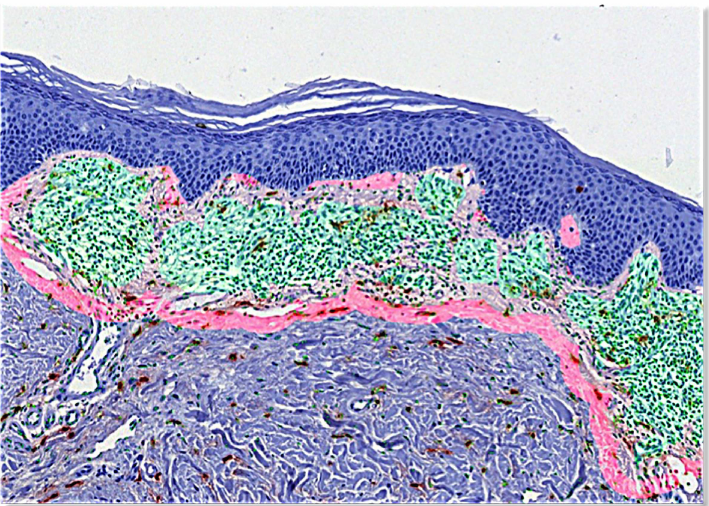
Fig 3. Regions of interest. Lymphoma infiltrate: green. P1 (0 to 30 micron from lymphoma infiltrate): light pink. P2 (30 and 60 micron from lymphomainfiltrate): pink.